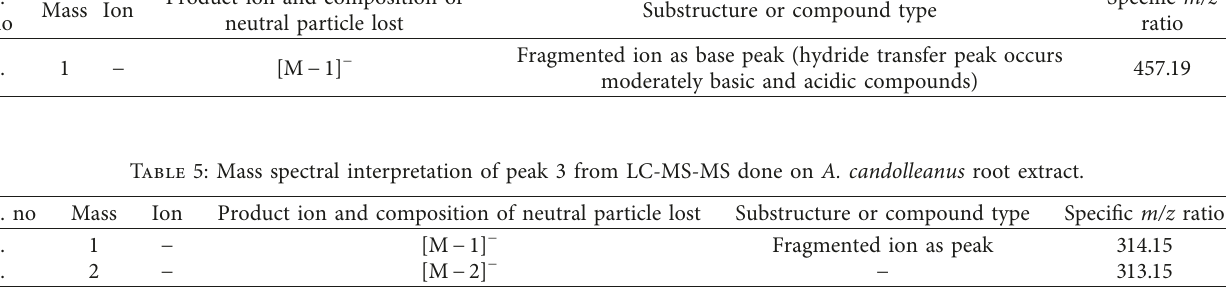
Table 4: Mass spectral interpretation of peak 1 from LC-MS-MS done on A. candolleanus root extract. S.